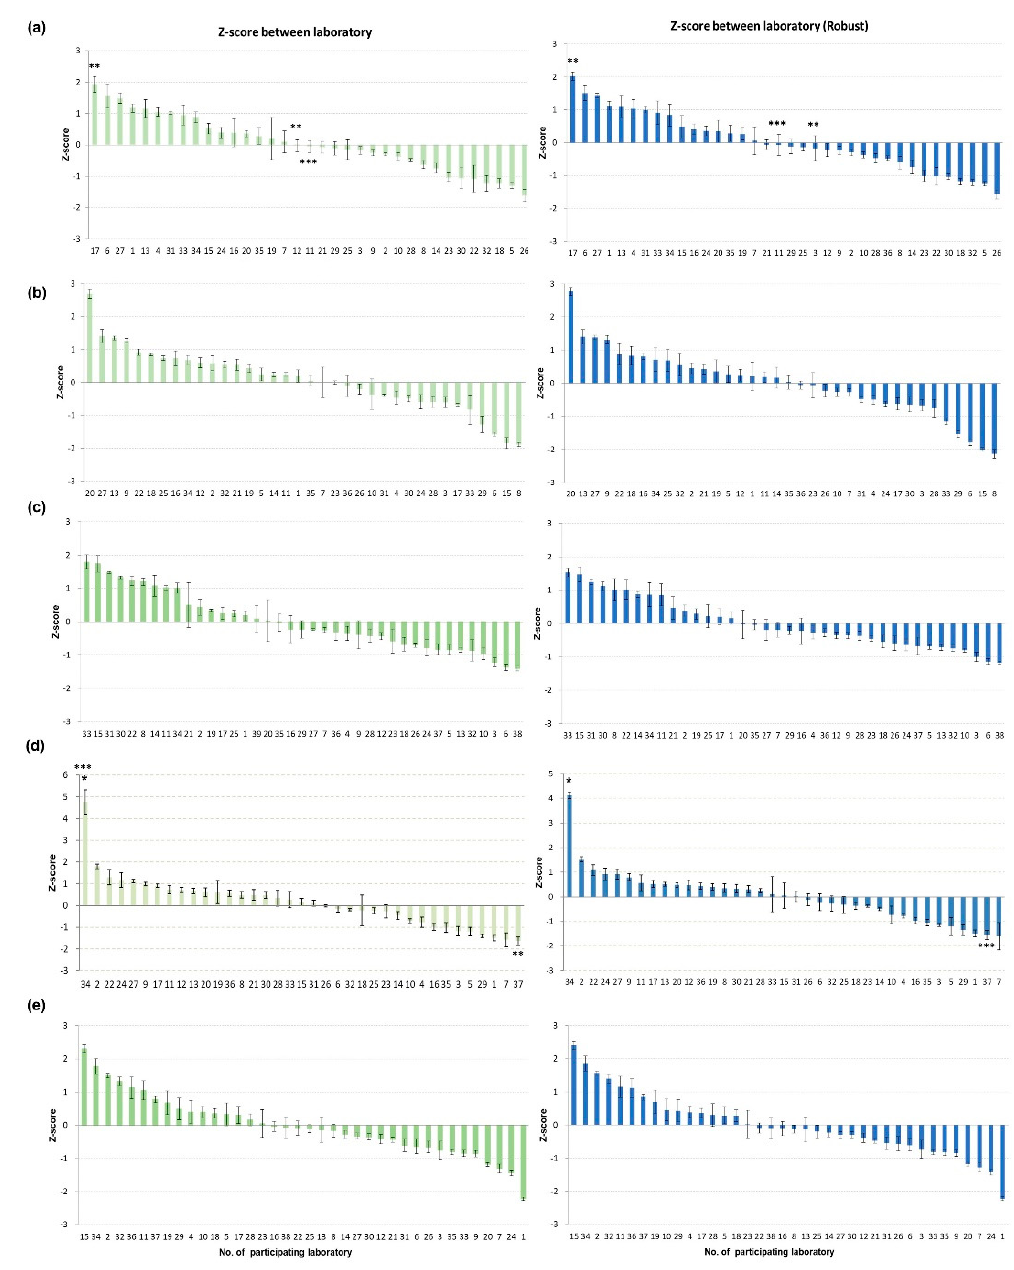
Figure 1. Graph of Z − scores between laboratories during five PT rounds. Z − scores were analyzed for Ct values of the common sample pairs submitted by all participating laboratories in ( a ) 2020 first half, ( b ) 2020 second half, ( c ) 2021 first half, ( d ) 2021 second half, and ( e ) 2022. Z − scores between laboratories were calculated with two methods: classical statistics using average and standard de- viation (green), and robust statistics using median and normalized interquartile range (NIQR). * outlier lab, ** lab not detecting H5 gene in CDS, and *** lab reporting false − positive for AI negative sample.